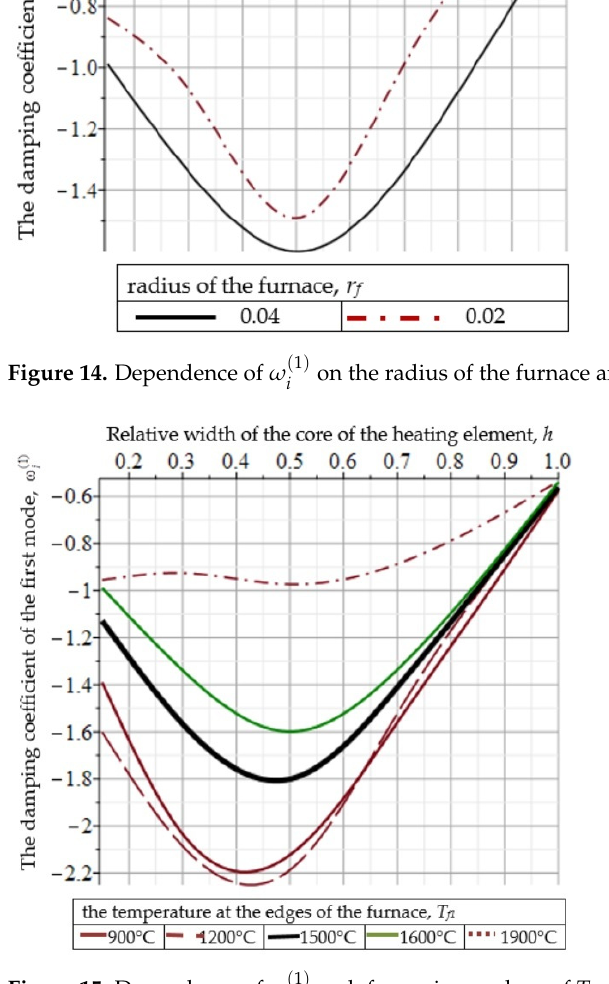
Figure 15. Dependence of ω (1)